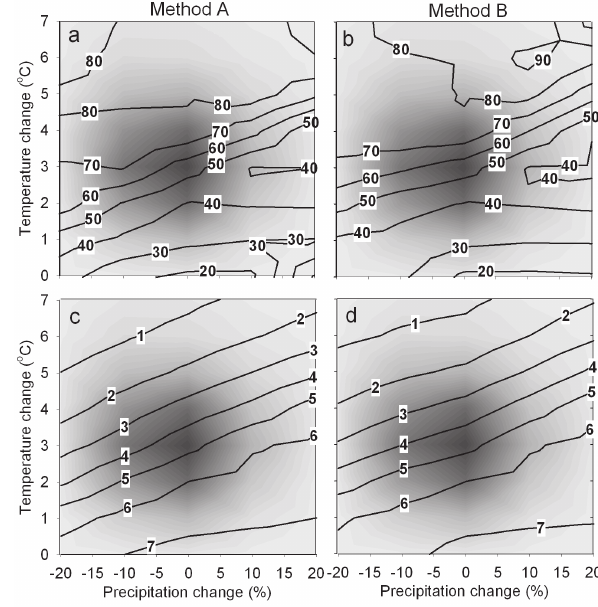
Fig. 3. Mean simulated N leaching (kg N ha − 1 ) ( a and b ) and grain yield (Mg DM ha − 1 ) of winter wheat (c and d) as contour lines for loamy sand in Denmark for changes in temperature and precipitation using method A ( a and c ) and method B ( b , d ). The background shading shows the probability (%) of changes in air temperature and precipitation during 2061–2080 for Denmark com- pared to the baseline period 1961–1990. The simulations used the CO 2 concentration for 2070 (611ppm). The legend for the shading is shown in Fig.